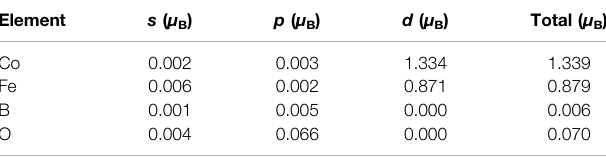
TABLE4| Magneticmomentsof s , p , d ,andTotalorbitalsfortheatomsintheCo- Fe-B-O system.